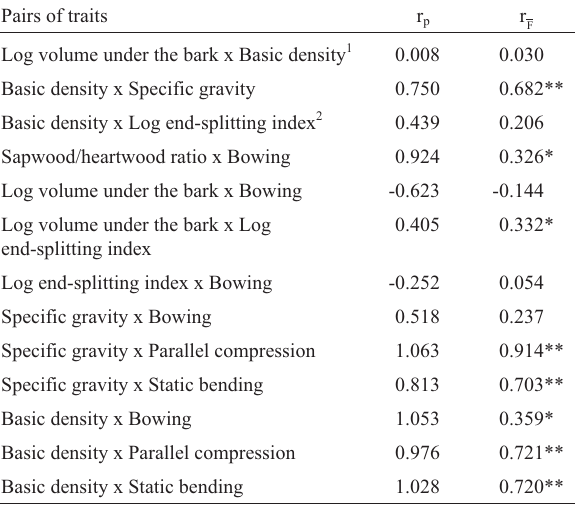
Table 4 - Estimates of the genetic correlation coefficients among progenies (r p ) and the phenotypic correlation coefficients among progeny ) for pairs of traits of interest in relation to sawn timber means (r F production in eight-year-old E. grandis